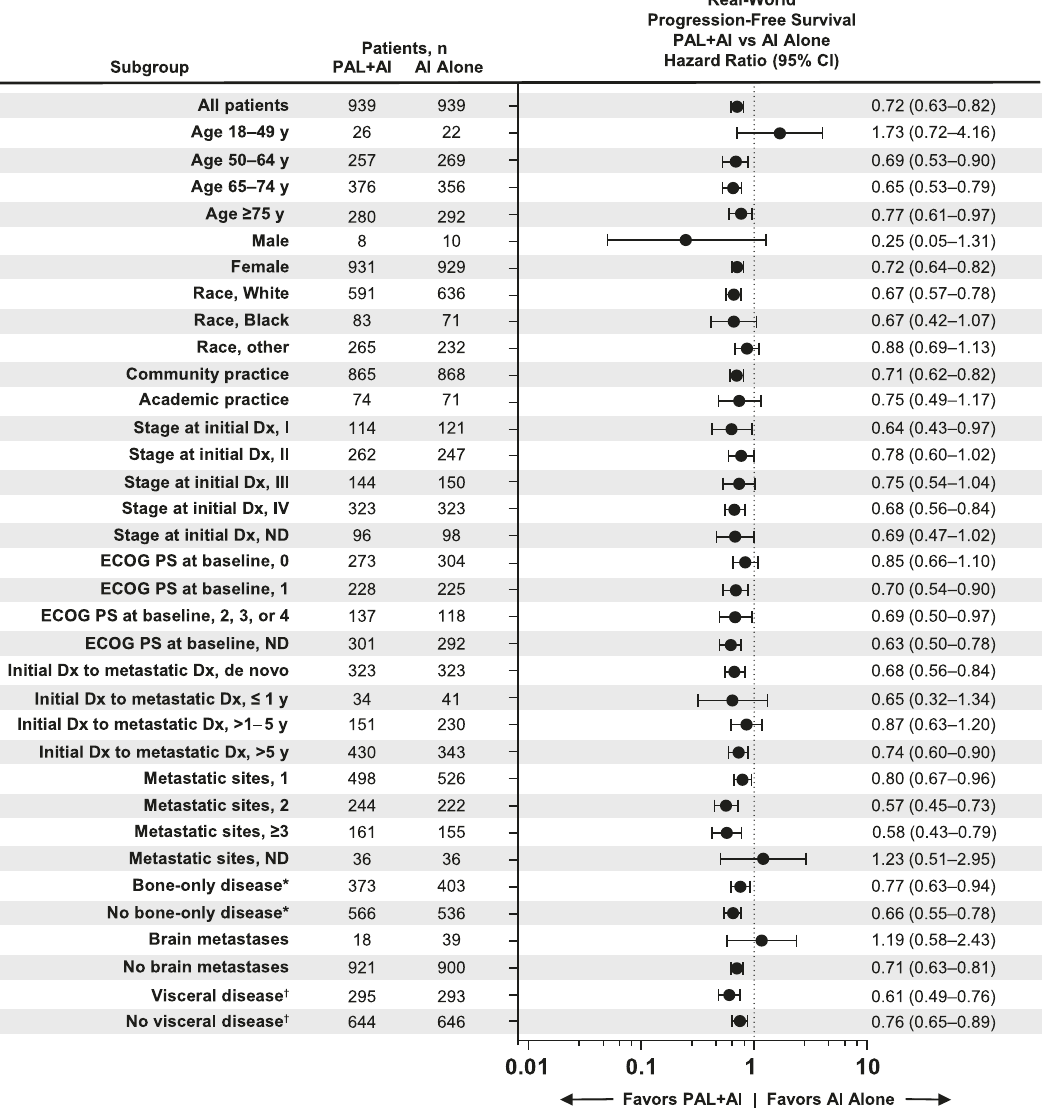
Fig. 7 Forest plot of real-world progression-free survival by subgroup after PSM. AI aromatase inhibitor; Dx diagnosis; ECOG PS Eastern Cooperative Oncology Group performance status; ND not documented; PAL palbociclib; PSM propensity score matching. * Bone-only disease was de fi ned as metastatic disease in the bone only. † Visceral disease was de fi ned as metastatic disease in the lung and/or liver; patients could have had other sites of metastases. No visceral disease was de fi ned as no lung or liver